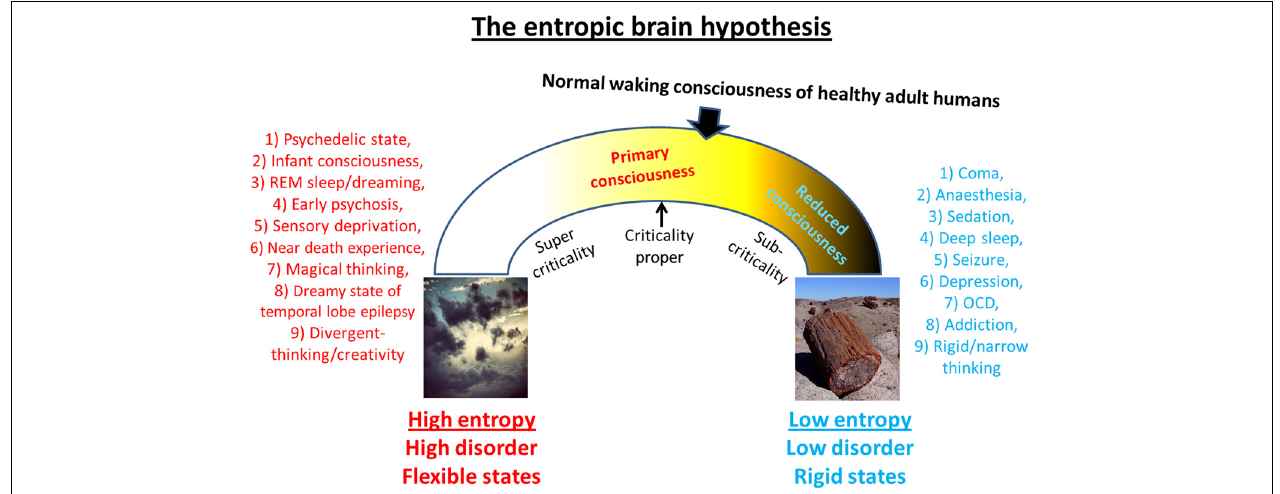
FIGURE 7 | Spectrum of cognitive states. This schematic is intended to summarize much of what this paper has tried to communicate. It shows an “inverted u” relationship between entropy and cognition such that too high a value implies high flexibility but high disorder, whereas too low a value implies ordered but inflexible cognition. It is proposed that normal waking consciousness inhabits a position that is close to